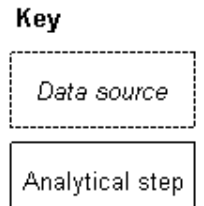
Figure 4. Structure of the paper and the applied